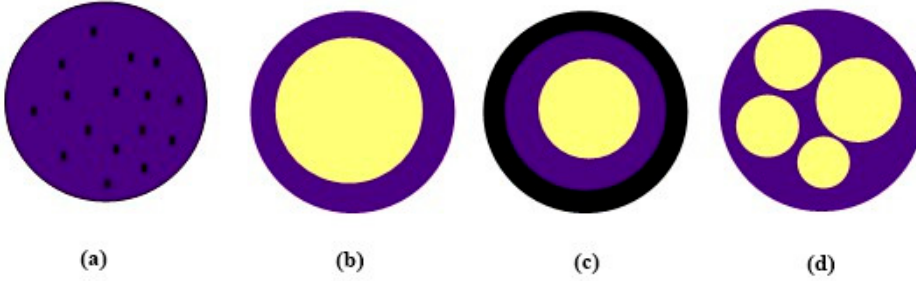
Figure 1. Morphologies of microcapsules: ( a ) microsphere (matrix type), ( b ) core/shell, ( c ) core/multi-shell and ( d ) multicore/shell.